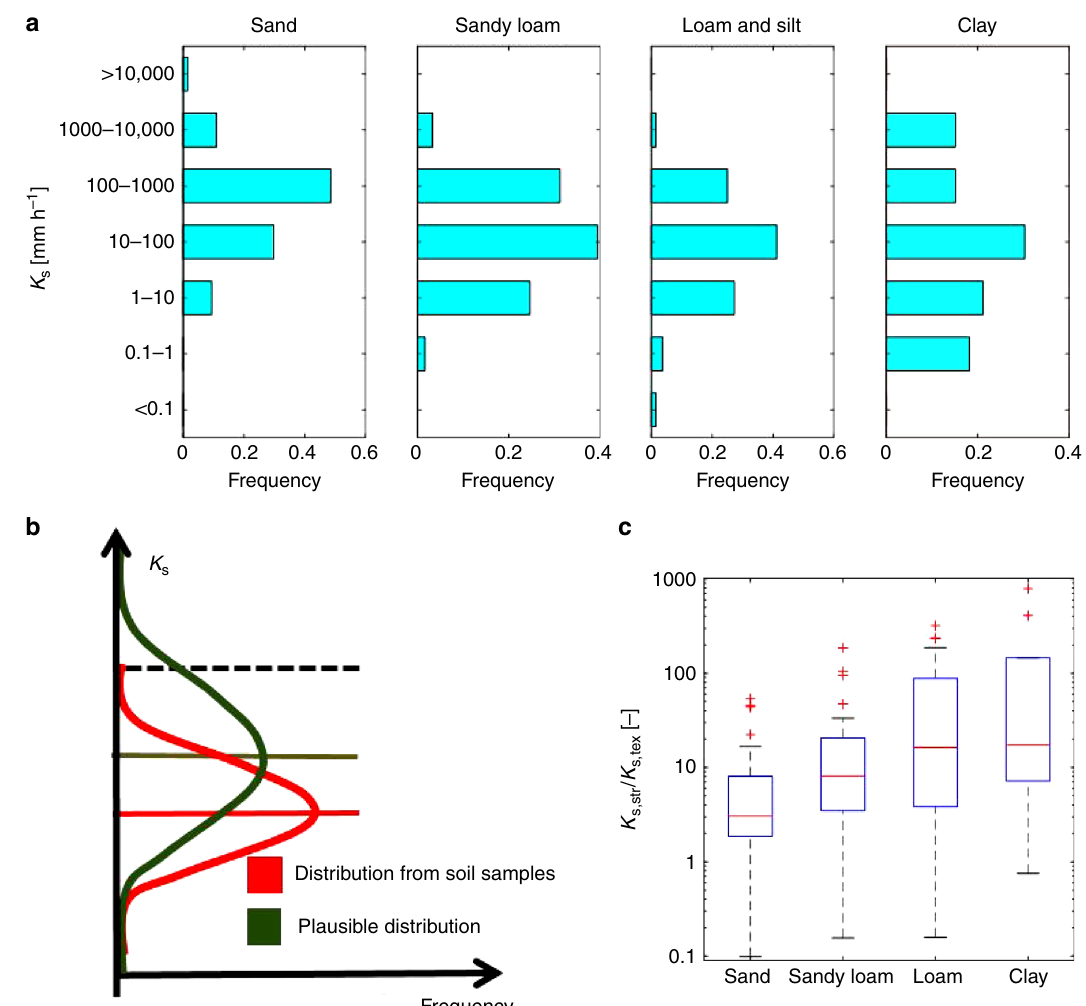
Fig. 1 Biases in current soil hydraulic conductivity parameterizations. a Distribution of saturated hydraulic conductivity subdivided for soil-textural types (sand, sandy loam, silt and loam combined, and clay) for undisturbed samples only of the UNSODA database (Nemes et al. 46 and Børgesen et al. 47 ). b Hypothetical distributions of soil saturated hydraulic conductivity ( K s ) obtainable from soil cores vs. rarely observed structured soil samples. The dashed line delimits the largest value of K s related to texture. Solid lines are the medians of the two distributions. c Distribution of the ratio between structural and textural saturated conductivity K s,str / K s,tex subdivided for soil-textural types (data from Weynants et al. 39 ). The box length provides the interquartile range (IQR), the bottom of the box the 25th percentile ( fi rst quartile, q1), the top of the box the 75th percentile (third quartile, q3), and the horizontal line within the box the median value. The lower whisker corresponds to q1 − 1.5IQR and the upper whisker corresponds to q3 + 1.5IQR; outliers are plotted